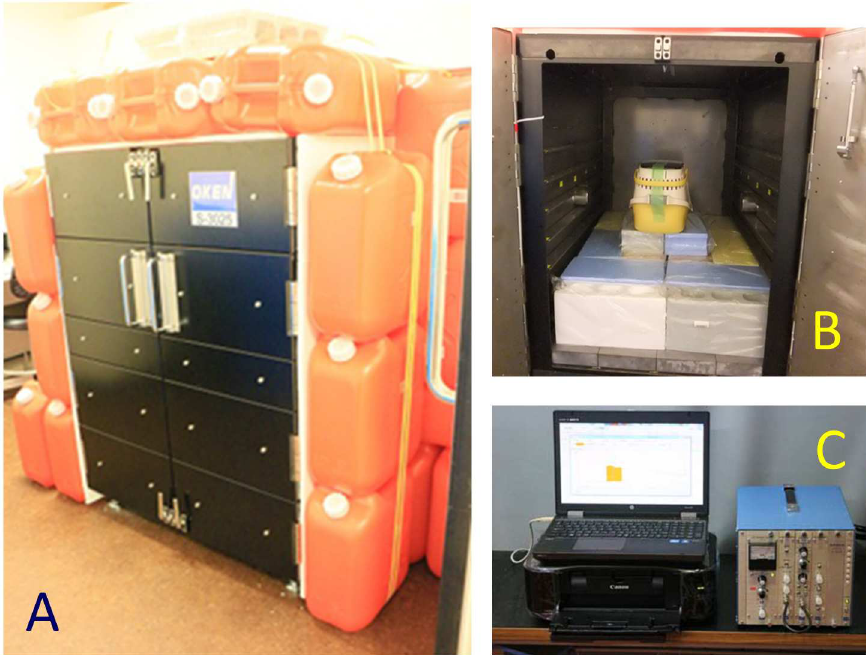
Fig 1. A: Front view of the detection tank of the whole-body counter. The entire surface, includingthe door, is coveredwith lead plates. The four vertical outer faces (front, back, left, right) were shieldedwith water. B: Inside the detectiontank. The animal cage can be seen on top of polystyreneblocks. The NaI radiation detectors lie on both sides. C: High-voltage power supply, linear amplifier, multi-channel pulse height analyzer and radioactivity